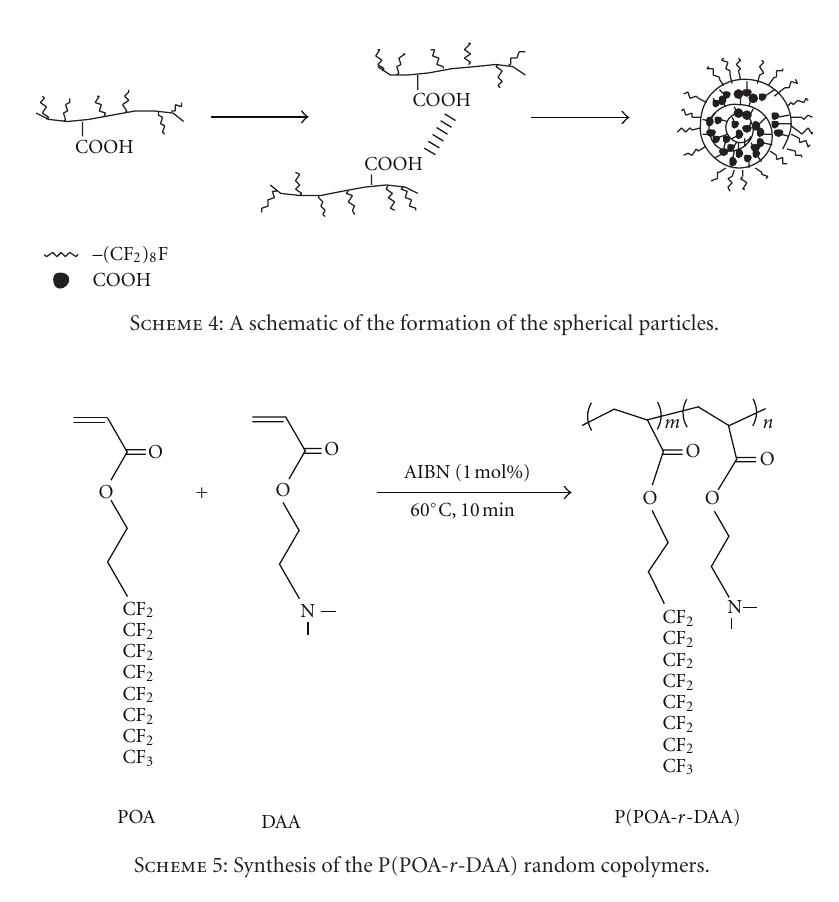
Table 2: The P(POA- r -AA) copolymers.